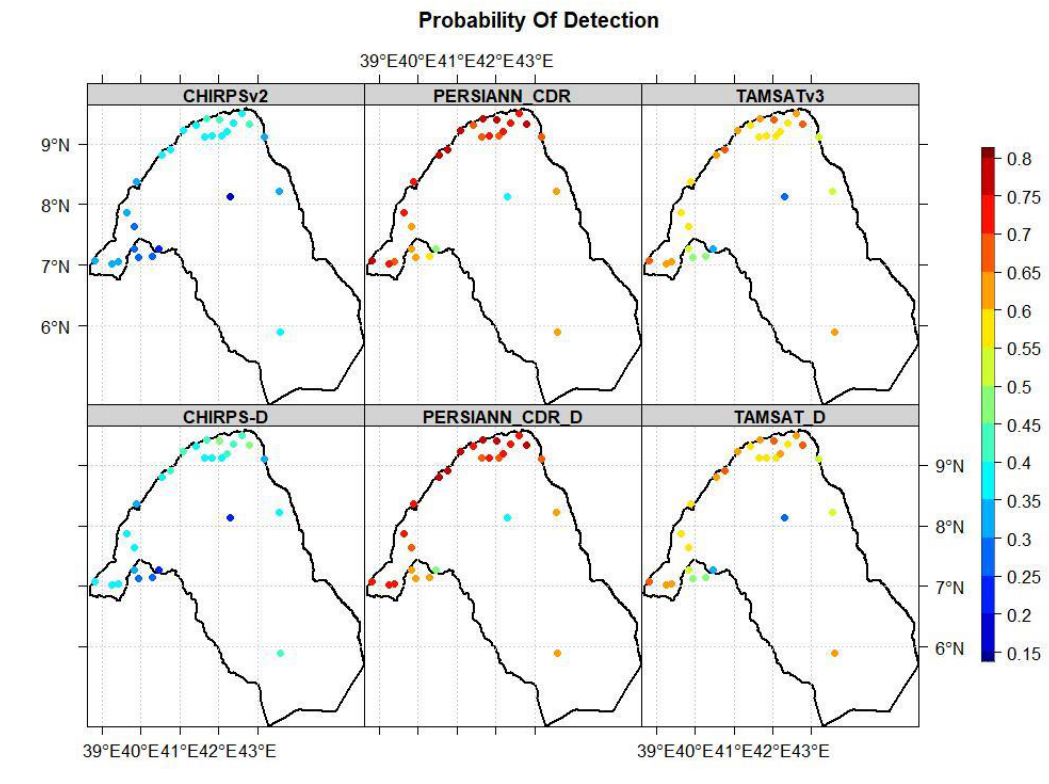
Figure 4. The probability of detection for each station at a daily timescale.